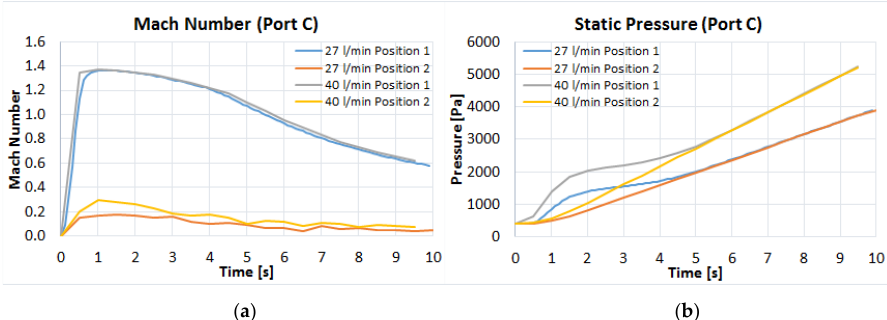
Figure 18 . Mach number ( a ) and pressure ( b ) versus time, C port, 27 and 40 L/min. Figure 18. Mach number ( a ) and pressure ( b ) versus time, C port, 27 and 40 L/min.